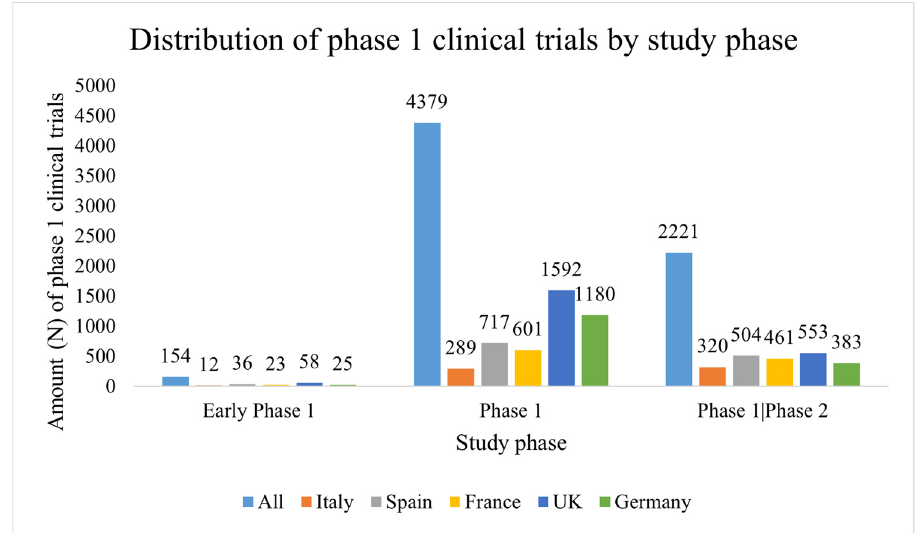
Figure 2. Distribution of phase 1 clinical trials by study phase. The total number of registered phase 1 clinical trials on ClinicalTrials.gov was divided by country and study phase. Five European countries were selected: France, Germany, Italy, Spain and the UK. The period from 1 January 2012 to 31 December 2021 was taken into consideration. Early phase 1 vs. phase 1: p -value = 0.0192; Early phase 1 vs. phase 1/phase 2: p -value = 0.0003.